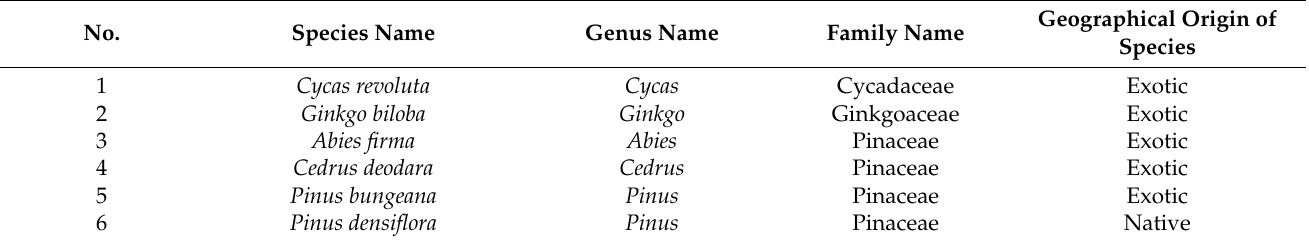
Table A1. Checklist of heritage trees in Jiangsu Province, eastern China. “Native” in the column of “Geographical origin of species” refers to the species naturally occurring in Jiangsu Province while “Exotic” refers to the species cultivated in